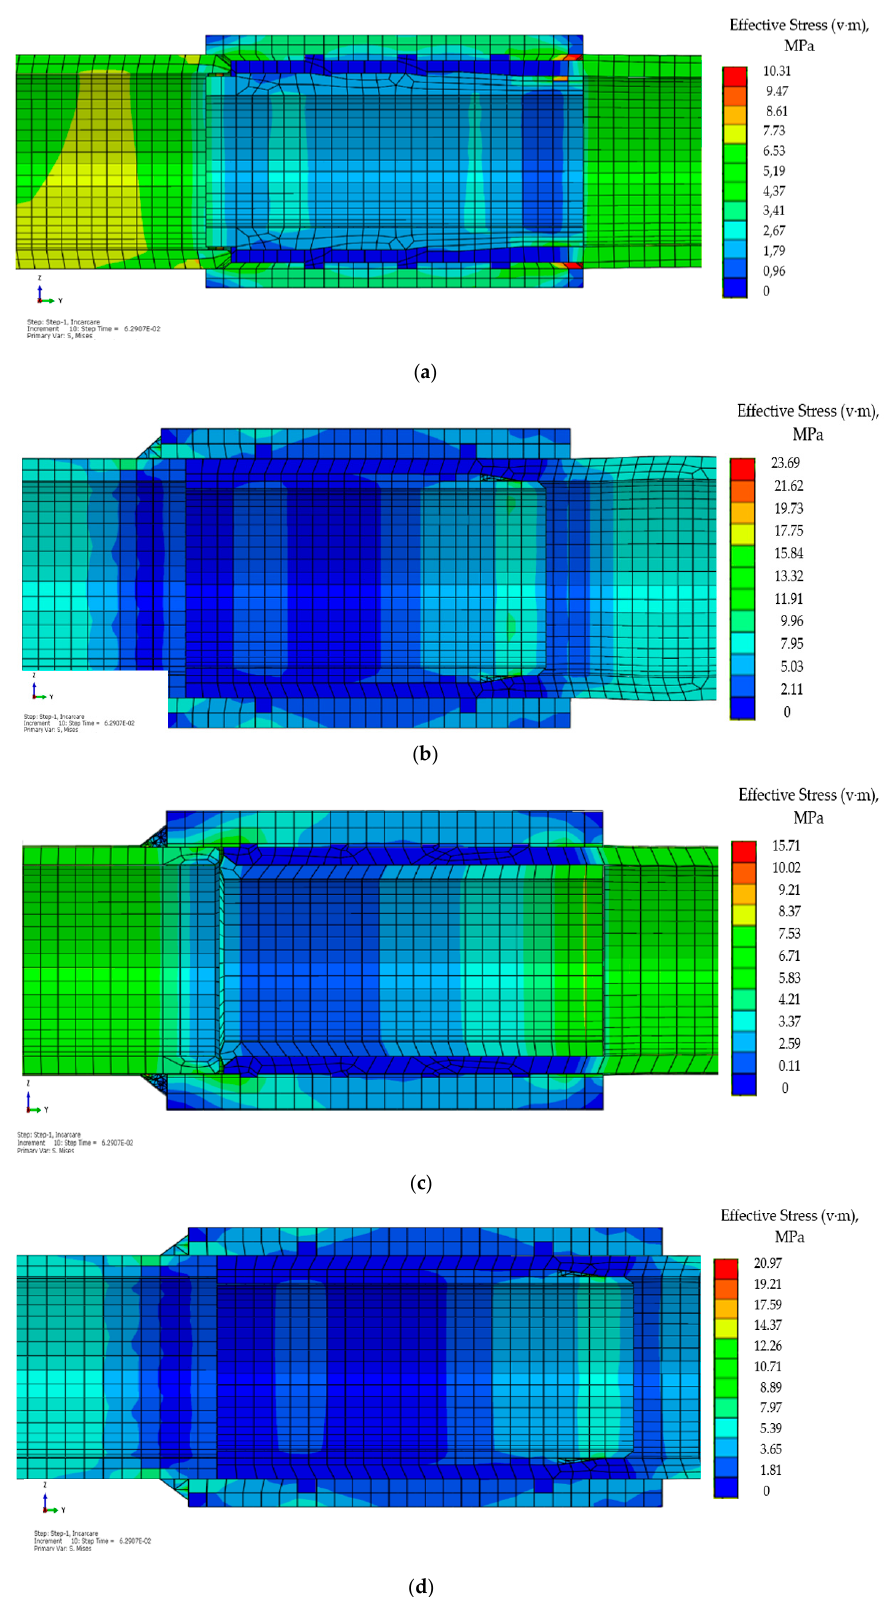
Figure 6. FEM analysis for the four types of transition fittings: ( a ): T1 fitting; ( b ): T2 fitting; ( c ): T3 fitting; ( d ): T4 fitting. fitting; ( d ): T4